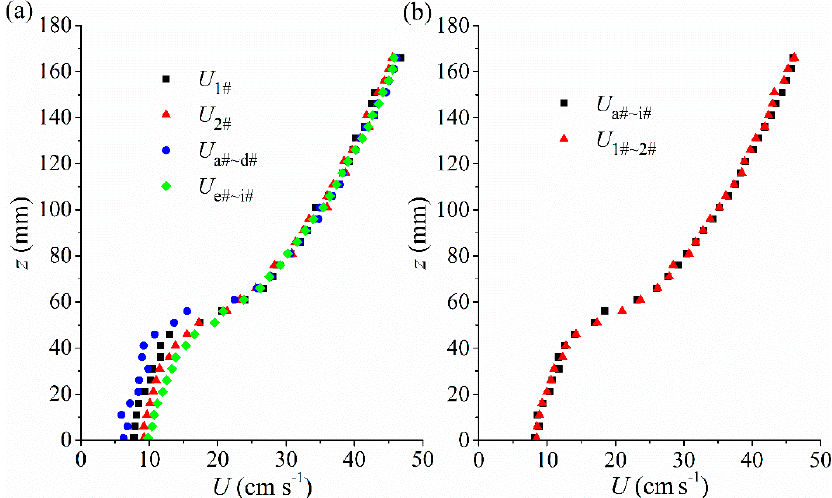
Figure 3. ( a ) Spatial variations of the velocity profiles and ( b ) the comparison between U 1#~2# profile and the U a#~i# one in Case V.